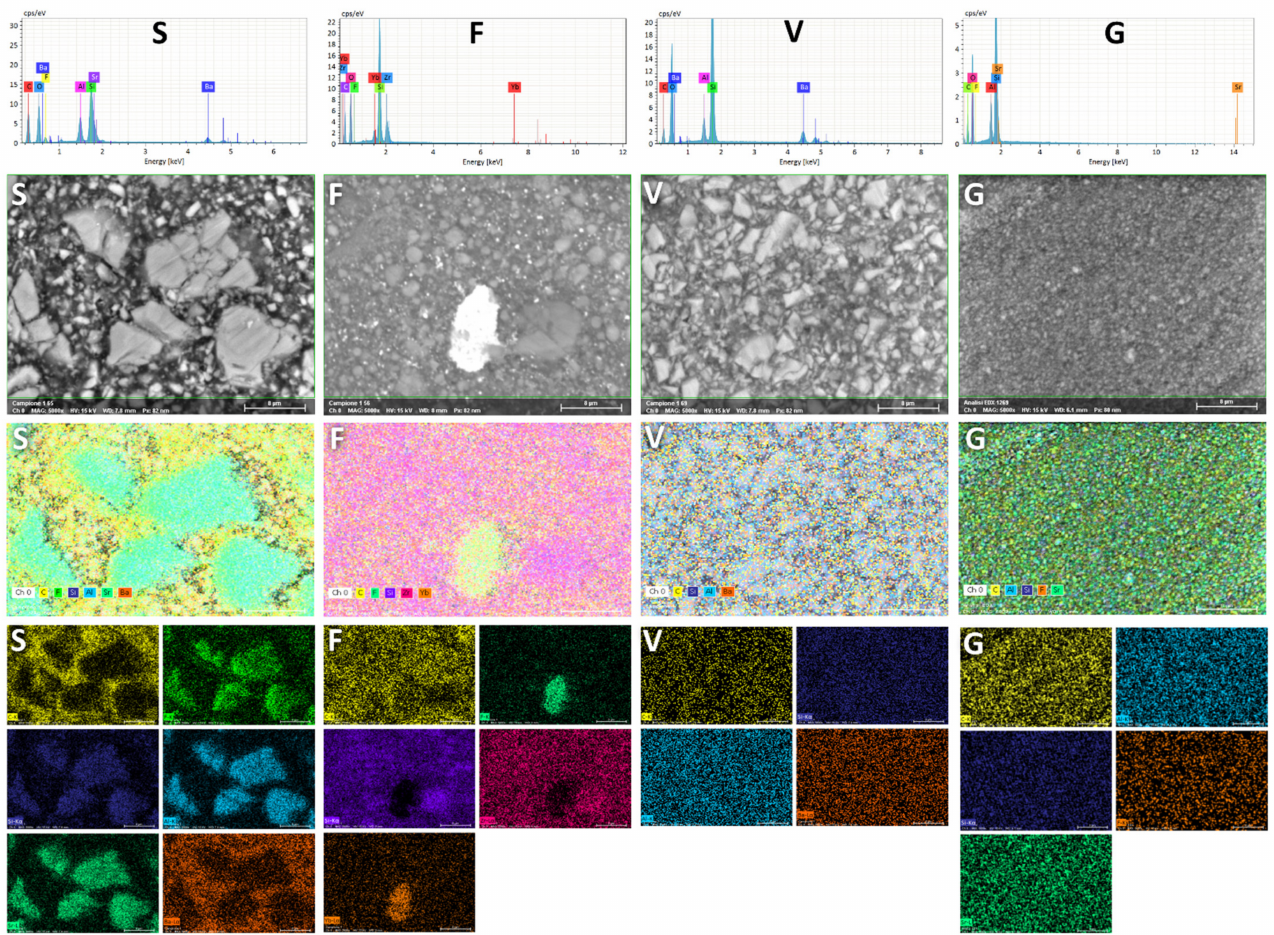
Figure 2. EDS analysis. For each tested polymeric material, from top to bottom are shown a typical spectrum of the surface showing elemental detection, an SEM backscattered micrograph at 5000 × , the superimposed false-color image showing elemental detection and smaller pictures depicting each acquired channel. It can be clearly seen that the fillers of the SDR material ( S ) appear very similar in shape, dimension and composition to a resin-based glass ionomer material (F-Al-Si-Sr glass) to which micronized barium glass was added. Filtek Bulk Fill ( F ) shows nanoparticles and clusters of YbF 3 embedded in silica and zirconia nanoparticles and nanoclusters. The composition of Admira Fusion X-tra ( V ) and Universal Flo ( G ) is extremely homogeneous, with the first belonging to the micro-hybrid resin composite class (microfillers+nanofillers) while the second one is